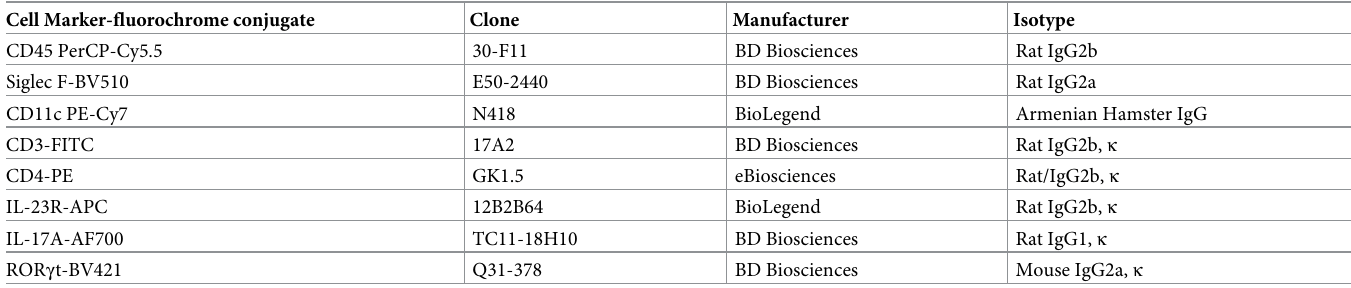
Table 1. Antibodies used for flow cytometry. Cell Marker-fluorochrome